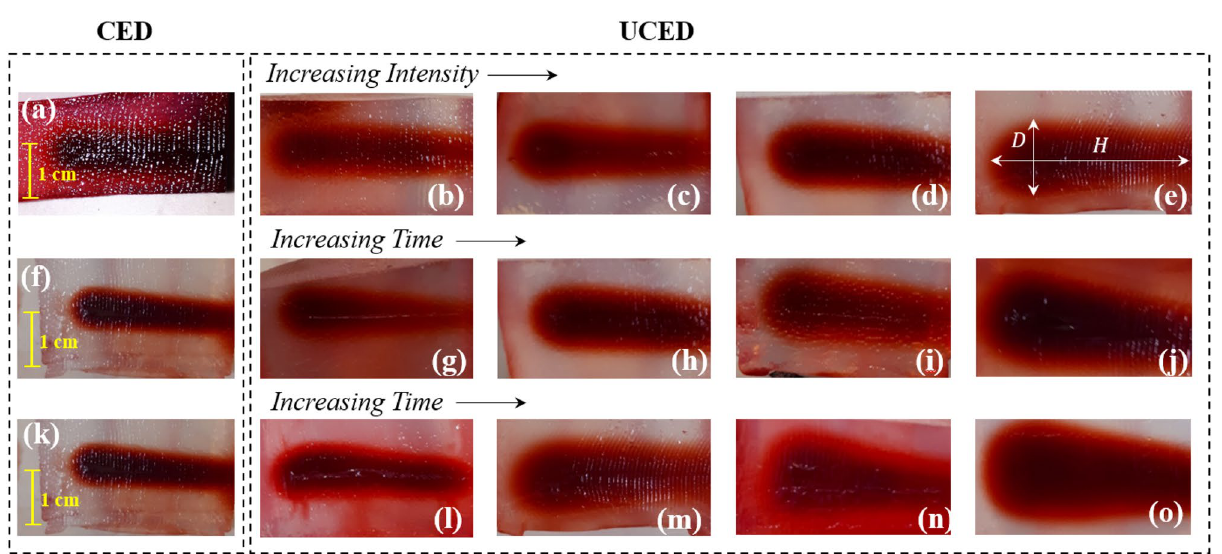
Figure 5. Drug distribution over the mid-surface of the brain-mimicking gels: The first row ( a-e ) depicts the variations of drug distribution over different ultrasound intensities (Experiment I). In this row, the left image depicts the CED sample after 30 min exposure time and the remaining four figures show the outcome of Experiment I, where ultrasound intensity changes according to the values in Table 1, from left to right In the second ( f-j ) and third row ( k–o ), the left image shows the CED sample’s result after 50 min exposure time and other four figures in each row are the results of Experiments II and III, showing variations of drug distribution with the increase of time, according to the values in Table 1. Subfigure ( e ) shows how the volume of the penetrated drug was calculated by a cylindrical calculation from parameters D and H UCED in brain‑mimicking gels. Right after the experiments (Table 1), each sample was cut at the mid- dle surface, as shown in Fig. 5a–o. As it is evident in this figure, FUS waves improve the drug distribution through the gels, and as the exposure time and the ultrasound intensity increase, the drug penetration depth ( D ) improves relative to CED. To better show the impact of ultrasound waves on drug distribution, CED samples are reported in the left figures of each row in Fig. 5. In order to better analyze the results of UCED in enhancing the drug delivery, a cylindrical distribution pattern was assumed, and the volume of each sample was approximated ⌣ V = π D 2 H / 4 , where D and H are respectively the diameter and height of the penetrated solution, as shown by in Fig. 5e. After quantifying the results of experiments, a better judgment can be made. From Fig. 6a, it can be concluded that the ultrasound waves have enhanced the drug volume distribution by about 226%, 275.7%, 308%,